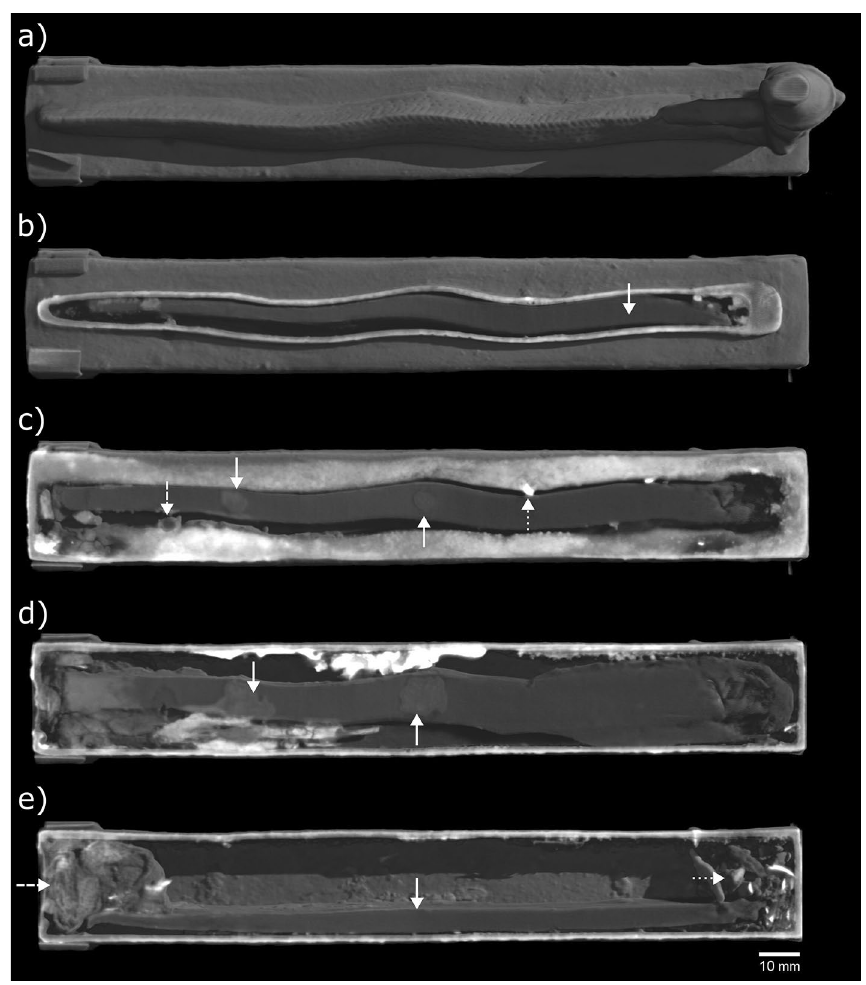
Figure 6. EA71428 neutron CT volume renders. ( a ) complete view of box; ( b )–( e ) cutaway views at different heights (measured from the box base): ( b ) 24.0 mm, through eel figure (solid arrow: upper lead piece inside hollow); ( c ) 21.3 mm, through top box wall (solid arrows: lead corrosion, dashed arrow: repair to box, dotted arrow: chaplet); ( d ) 17.7 mm, through base of upper lead piece (solid arrows: lead corrosion); ( e ) 12.9 mm, through box hollow (solid arrow: lower lead piece, dashed arrow: textile in plug, dotted arrow: loose